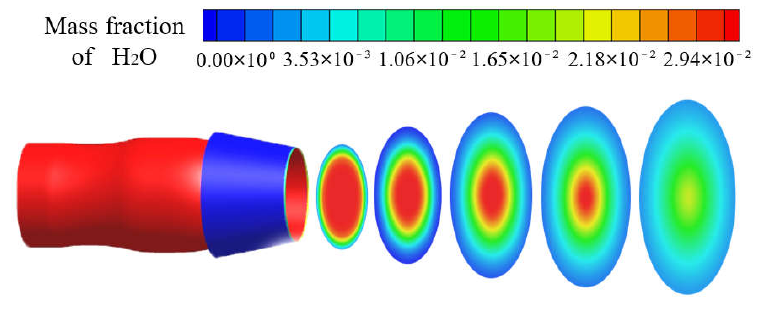
Figure 8. H 2 O mass fraction field distribution.